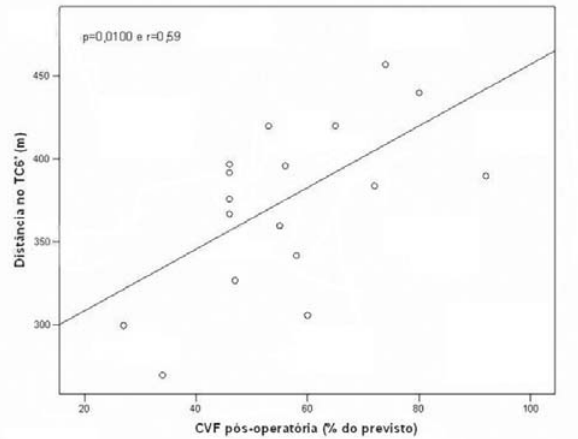
Fig. 2 - Correlação da distância no Teste de Caminhada de 6 minutos (TC6) com a Capacidade Vital Forçada (CVF) pós- operatória (n=18)